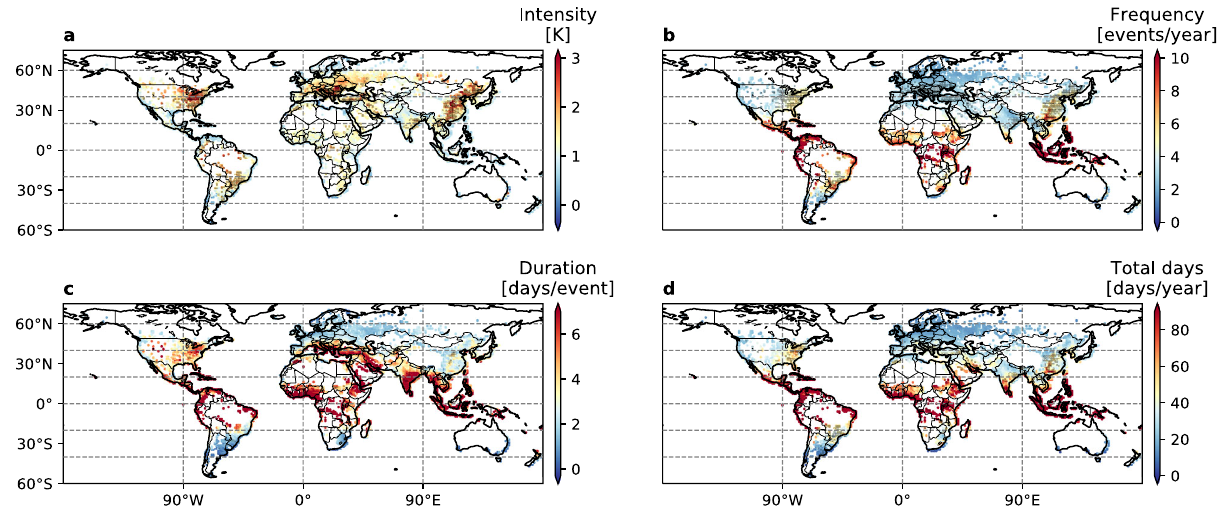
Fig. 2 Global multi-model ensemble projections of urban heat wave changes in 2061 – 2070 relative to 2006 – 2015. a intensity (K), b frequency (events per year), c duration (days per event), and d total days (days per year). Results are based on 17 selected Earth system models and the fi rst member of the CESM-LE runs. Stippling indicates substantial change (intensity > 1.5 K) with high inter-model robustness (SNR > 2.0).